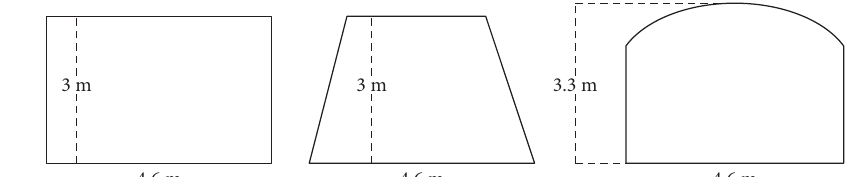
Figure 9: Different cross-sectional shapes.